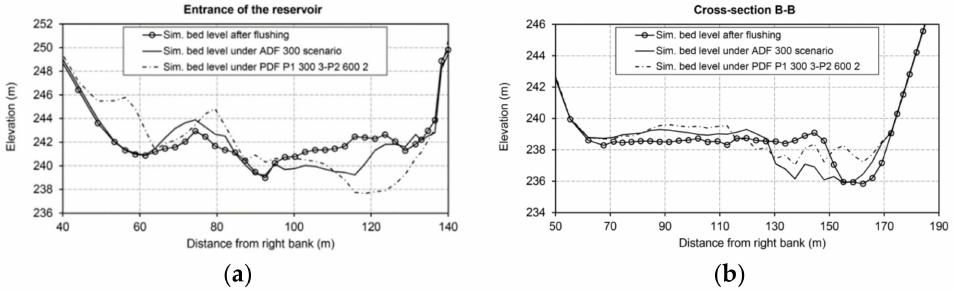
Figure 9. Simulated bed levels after flushing and under the ADF 300 and PDF P1 300 3-P2 600 2 scenarios at the location of ( a ) only the entrance of the reservoir; and ( b ) cross-section B-B. Location of cross-section B-B can be found in Figure